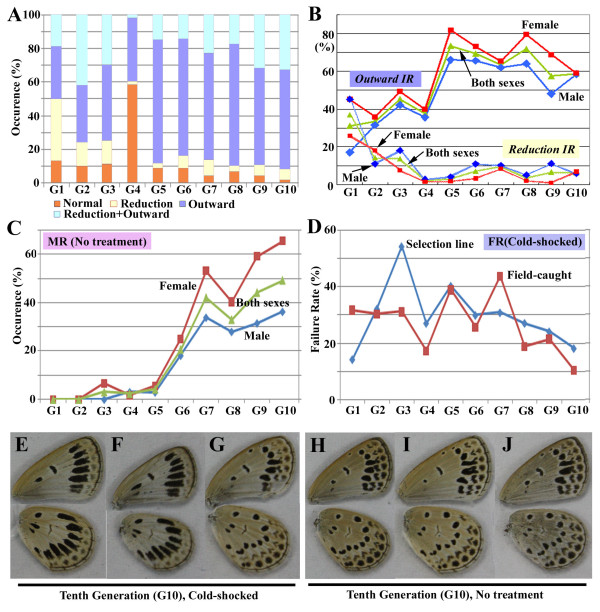
Selective breeding experiment for the outward type. (A) Modification-type profiles for generations (from the first generation [G1] to the tenth generation [G10]) after the cold-shock treatment. The fourth generation was treated differently, producing the smaller number of the modified individuals. The inward type was not produced. The outward type steadily increases until the fifth generation (G5). (B) The outward induction rate (IR) and reduction IR after the cold-shock treatment in males and females for generations. Females show higher outward IR than males do throughout generations. The outward IR appears to be in a plateau state after the fifth generation (G5). Males show higher reduction IR. (C) Modification rate (MR) for generations without immediate cold-shock treatment to pupae. As in the outward IR, females show higher MR than males do throughout generations. MR increases after the fifth generation (G5). (D) Failure rate (FR) after the cold-shock treatment for generations. FR of the selective line is less than 30% in G6 and in the following generations, indicating that the line is well maintained. The field-caught samples indicated by the red line were not genetically manipulated. Their parent females were caught freshly from the field to collect virgin adults for mating. (E-G) Modified individuals of the tenth generation (G10) in response to the cold-shock treatment. Both fore- and hindwings are severely modified as the outward type in many individuals. (H-J) Modified individuals of the tenth generation (G10) without immediate cold-shock treatment to pupae. Modifications are not severe but clearly observed.